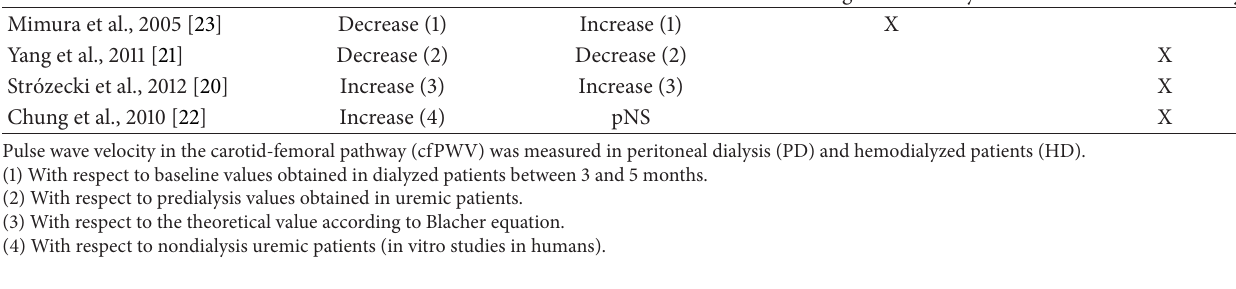
Table 4: Arterial (upper-limb or carotid-radial) stiffness in dialyzed